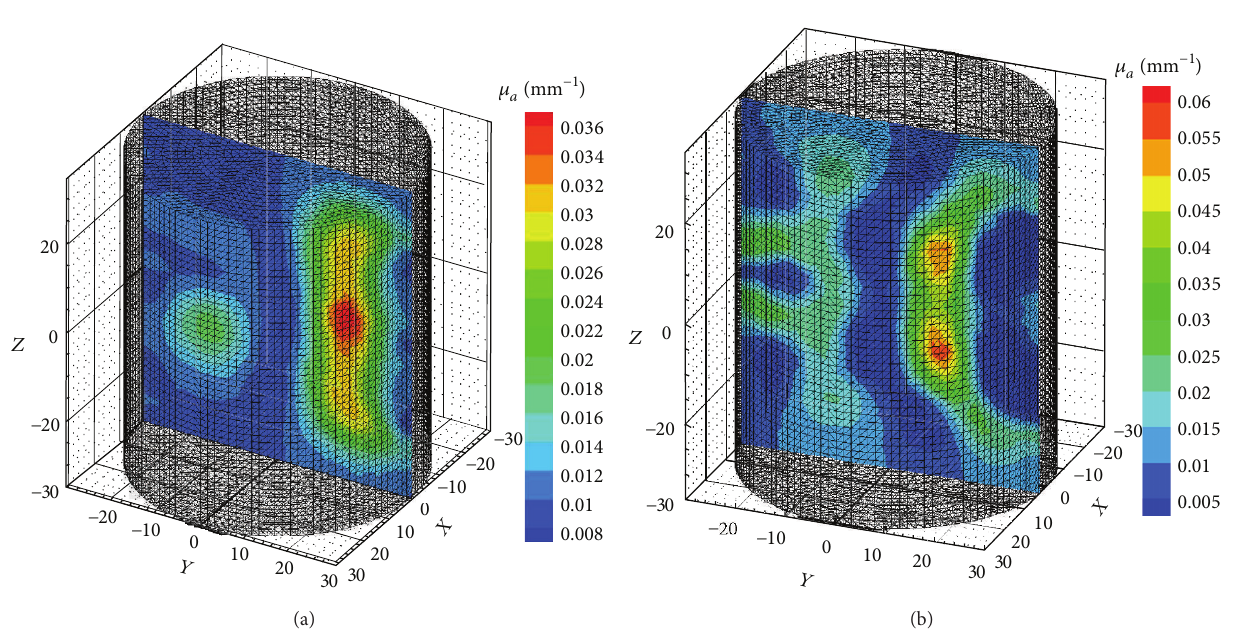
Figure 4: Reconstructed 3D images using C GPU C code (a) for simulation phantom. The phantom has two inhomogeneities, one cylindrical and the other spherical having 𝜇 𝑎 of 0.03 and 0.02 mm −1 , respectively, and (b) experimental phantom with two cylindrical inhomogeneities having diameters of 10 and 12mm and absorption coefficients of 0.02 and 0.035 mm −1 , respectively. The background absorption and scattering coefficients are 0.005 mm −1 and 0.8 mm −1 . The inhomogeneities run through the length of the